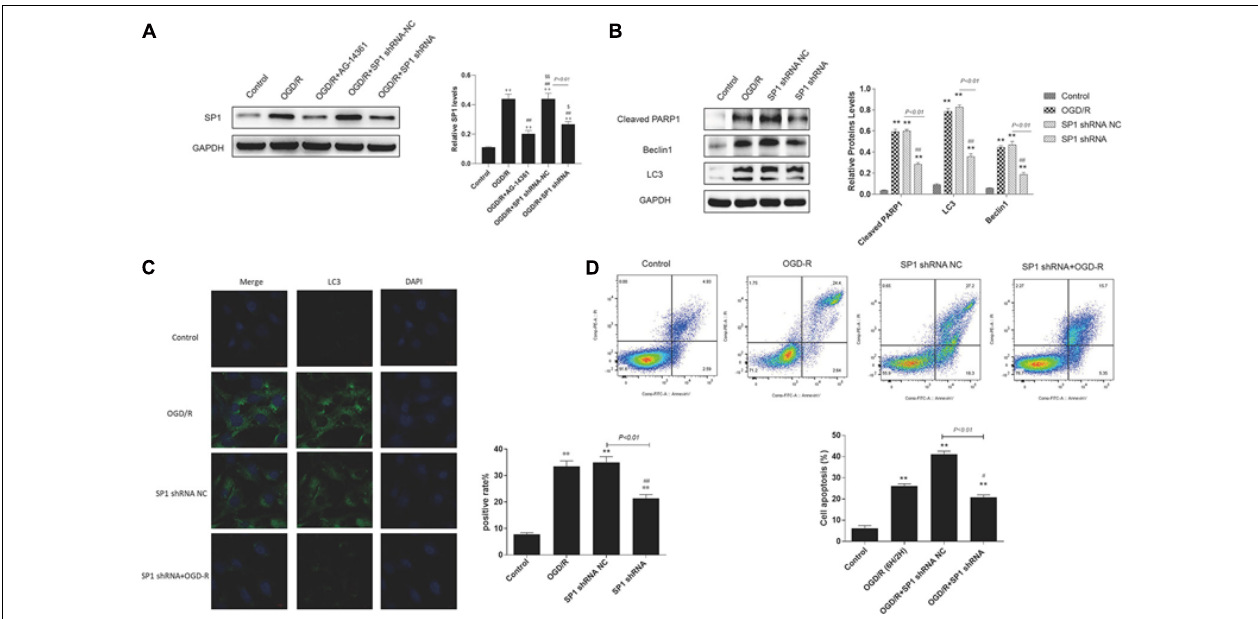
FIGURE 4 | Silencing Sp1 prevented cardiomyocytes from OGD/R. The OGD/R-modeled H9c2 cells were treated with Sp1 shRNA-NC and Sp1 shRNA. (A) Western blot assay showed the expression level of Sp1 when transfecting H9c2 cells with Sp1 shRNA and Sp1 shRNA-NC. (B) Western blot showed the expression of PARP1 and autophagy related proteins when treating H9c2 cells with Sp1 shRNA and Sp1 shRNA-NC. (C) GFP-LC3 assay showed the number of GFP puncta in H9c2 cells when treating H9c2 cells with Sp1 shRNA and Sp1 shRNA-NC. Magnification: 630 × . (D) Flow cytometry analysis showed the number of necrotic and apoptotic H9c2 cells when treating H9c2 cells with Sp1 shRNA and Sp1 shRNA-NC. Compared with control group, * P < 0.05, ** P < 0.01; compared with OGD/R group, # P < 0.05, ## P < 0.01. N = 4 for each group.